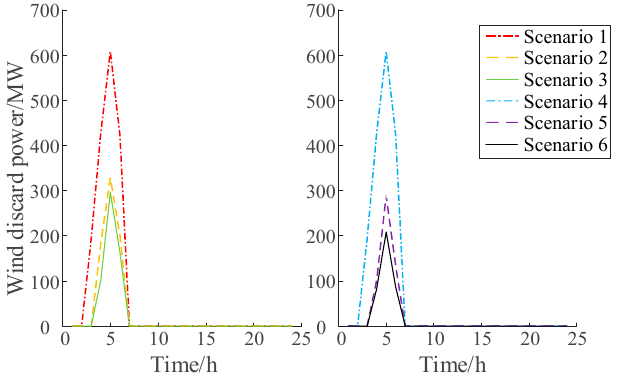
Figure 7. Wind power curtailment of di ff erent scenarios.